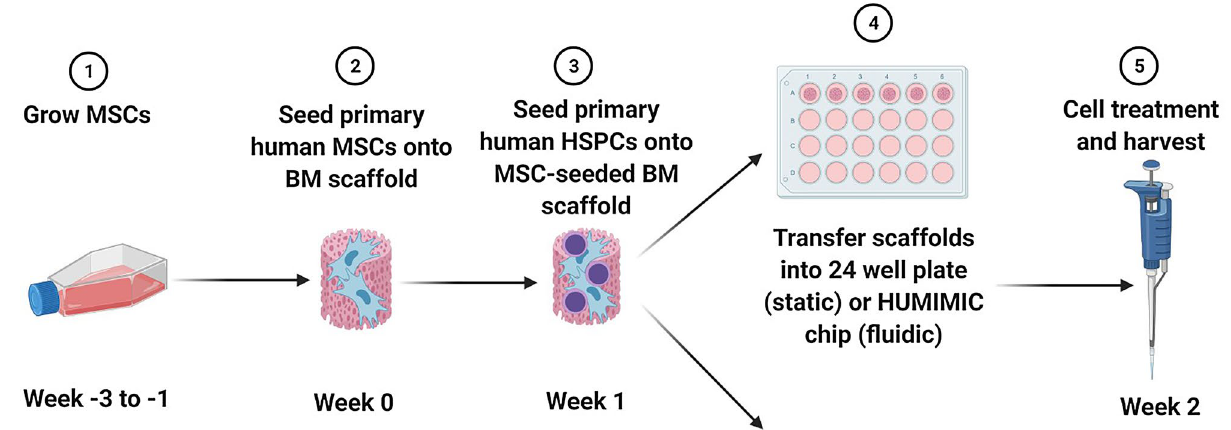
Figure 6. Schematic representation of 3D model study schedule. Created with BioRender.com.